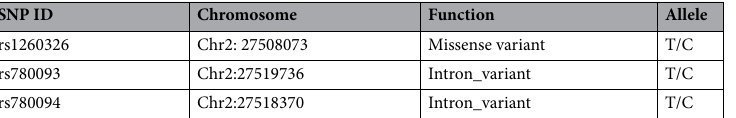
Table 2. The three SNPs in the GCKR gene analyzed in this study. Chr chromosome, GCKR glucokinase regulator, SNP single nucleotide polymorphisms.